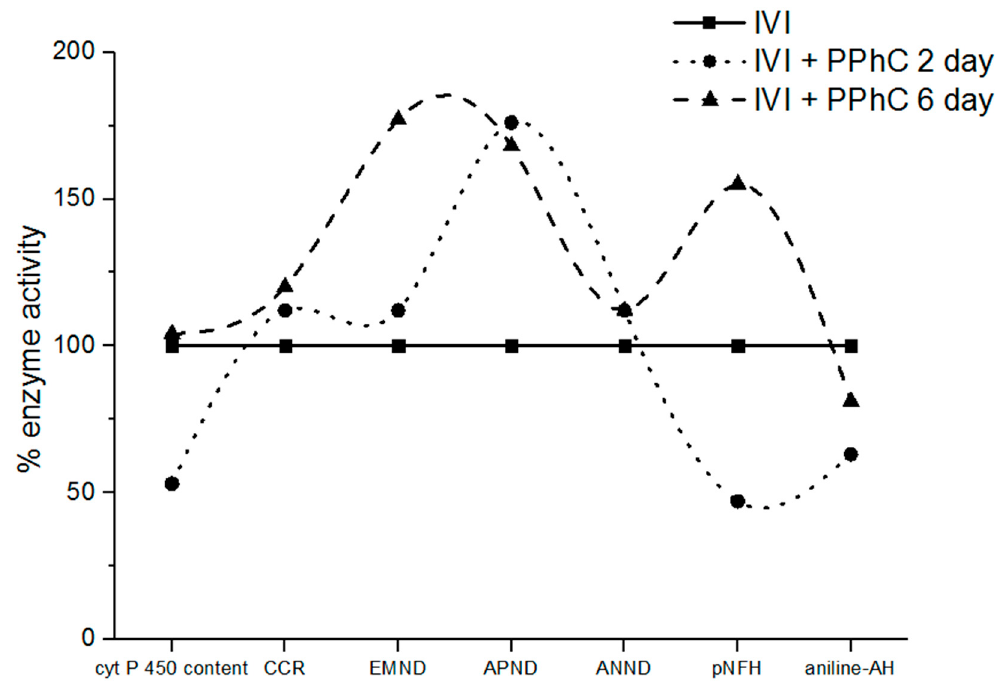
Figure 7. Panel of liver monooxygenase enzyme activities displaying the recovering effect of PPhC on the second and sixth day of IVI.